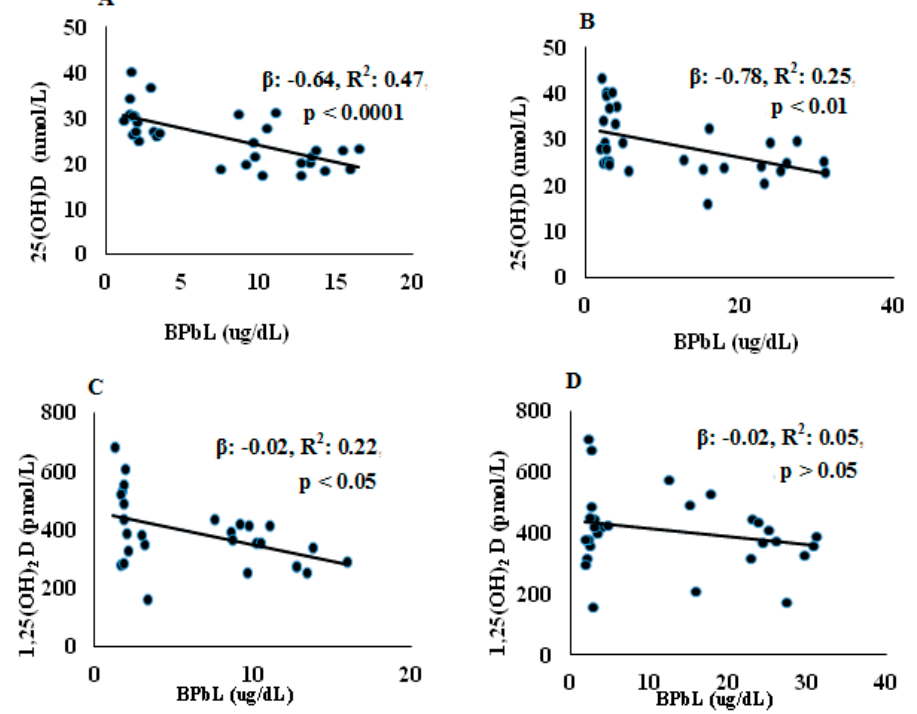
Figure 1. Association between BPbL and VD metabolites in control and Pb-exposed Wistar rat pups. Linear regression analysis was conducted between BPbL ( μ g/dL) and ( A ) 25(OH)D (nmol/L) in PND21 rats ( n = 39); ( B ) 25(OH)D (nmol/L) in PND30 rats ( n = 36); ( C ) 1,25(OH) 2 D (pmol/L) in PND21 rats ( n = 39); ( D ) 1,25(OH) 2 D (pmol/L) in PND30 rats ( n = 36).